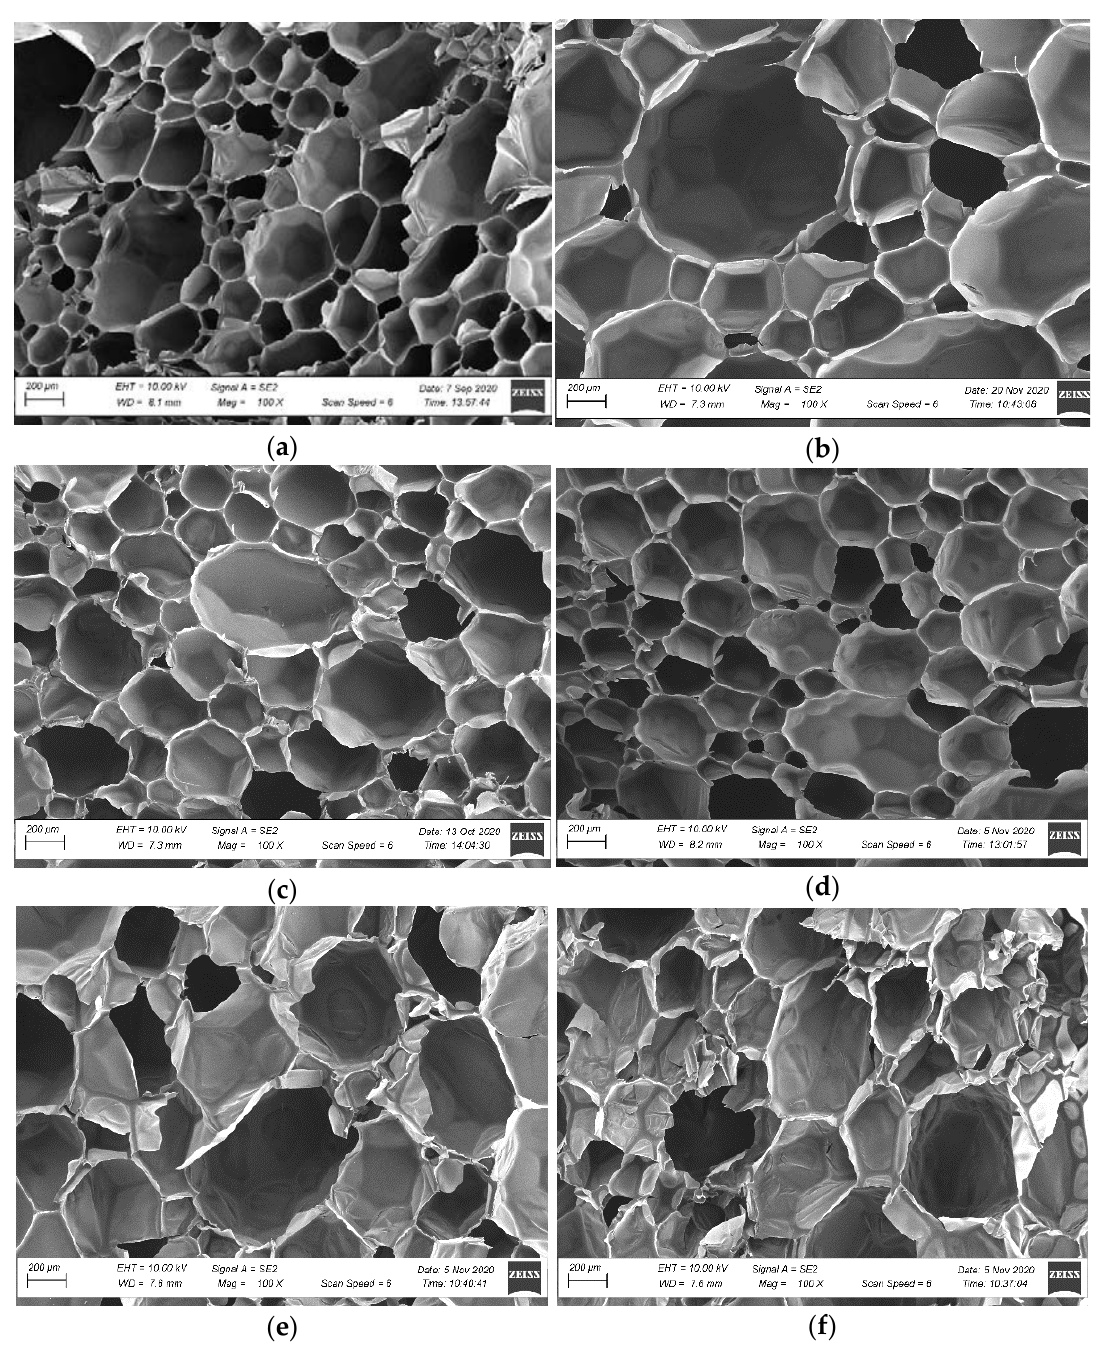
Figure 5. Microstructure of the cross-sectional surface of polyurethane adhesives in the bonds (magnification 100×) ( a ) OSB/23/50/8, ( b ) OSB/23/50/15, ( c ) OSB/25/30/8, ( d ) OSB/5/-/8, ( e ) OSB/25/90/8 and ( f ) OSB/25/90/8.